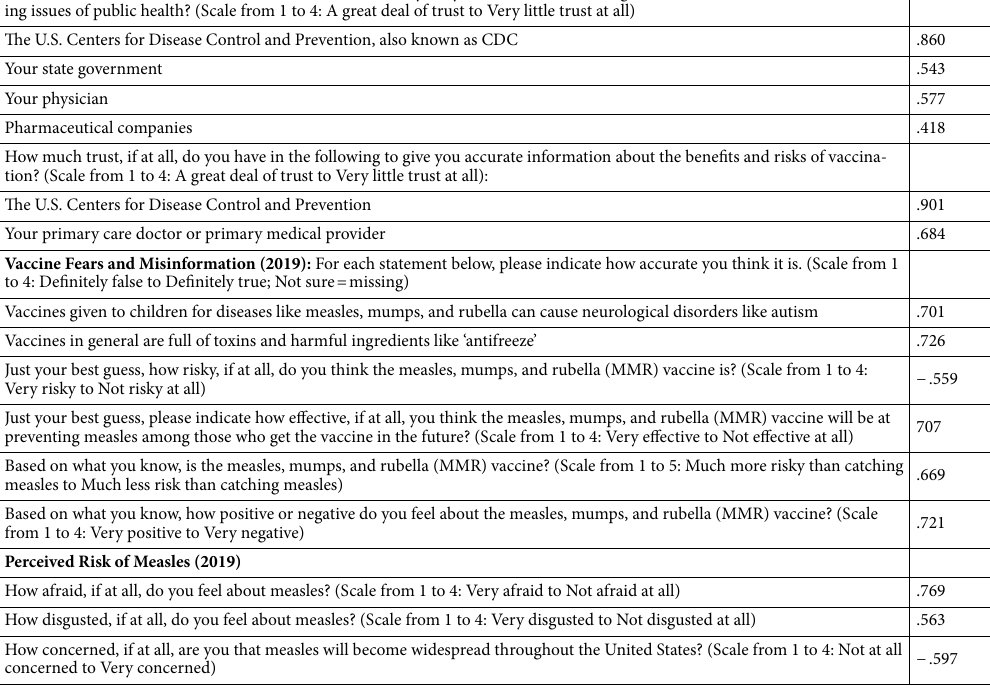
Table 3. Measures of trust, misinformation, and perceived risk of measles in 2019.